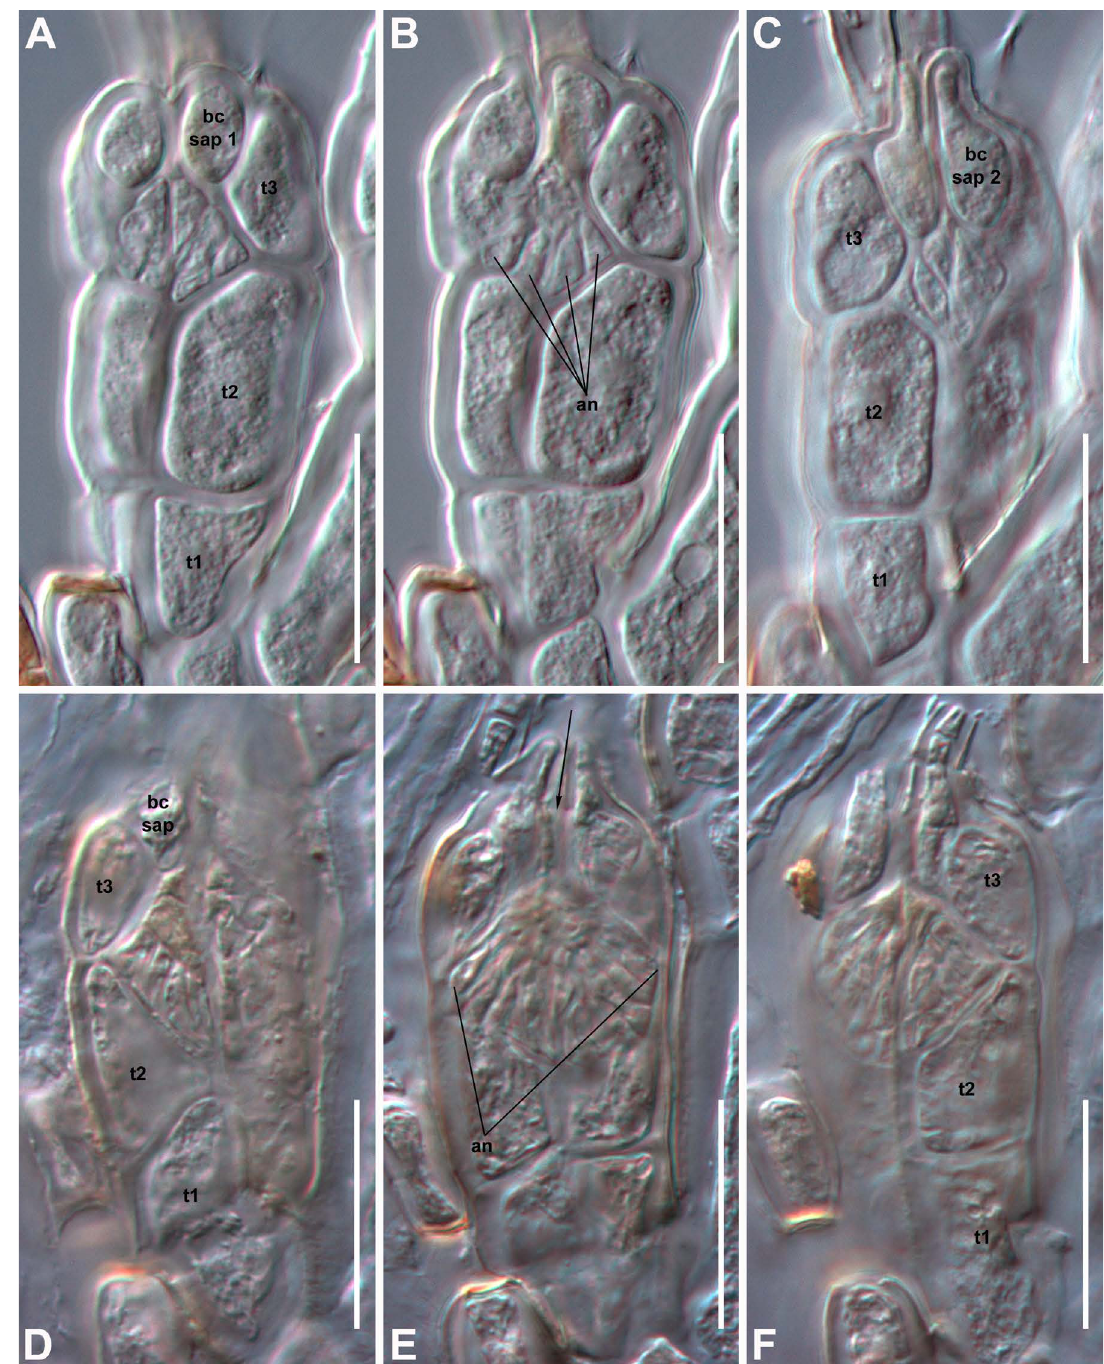
Fig. 88. Comparison of antheridia from Monoicomyces invisibilis Thaxt. and Eumonoicomyces papuanus Thaxt. A – C . M. invisibilis . Respectively, near, middle and far focus of antheridium in detail. The three tiers of paired cells are labelled (t1–3), the basal cells of secondary appendages (bc sap 1–2), and in the middle focus (B), “an” points to the four phialides. – D – F . E. papuanus . Respectively, near, middle and far focus of antheridium in detail. The three tiers of paired cells are labelled (t1–3), the basal cells of a secondary appendages (bc sap), and in the middle focus (E), “an” points to the phialides and the arrow to the opening through which the spermatia flow out. Scale bars: 20 µm. Photographs from slides